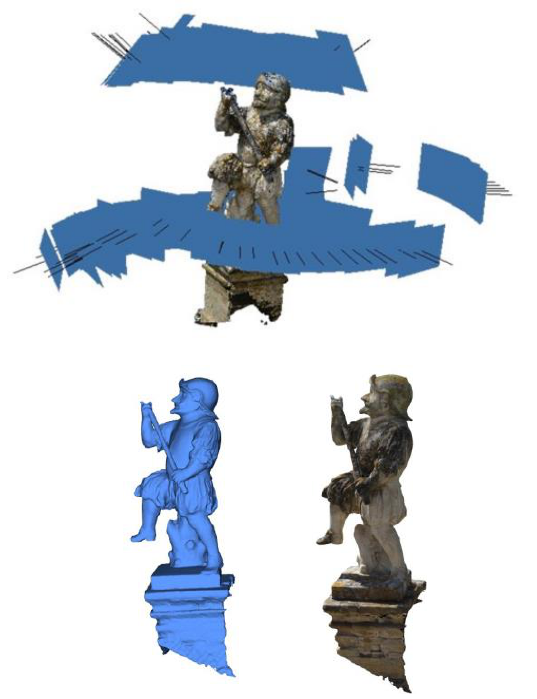
Figure 6. The survey of a statue: data acquisition on the top, 3D mesh (sx) and textured model (dx)